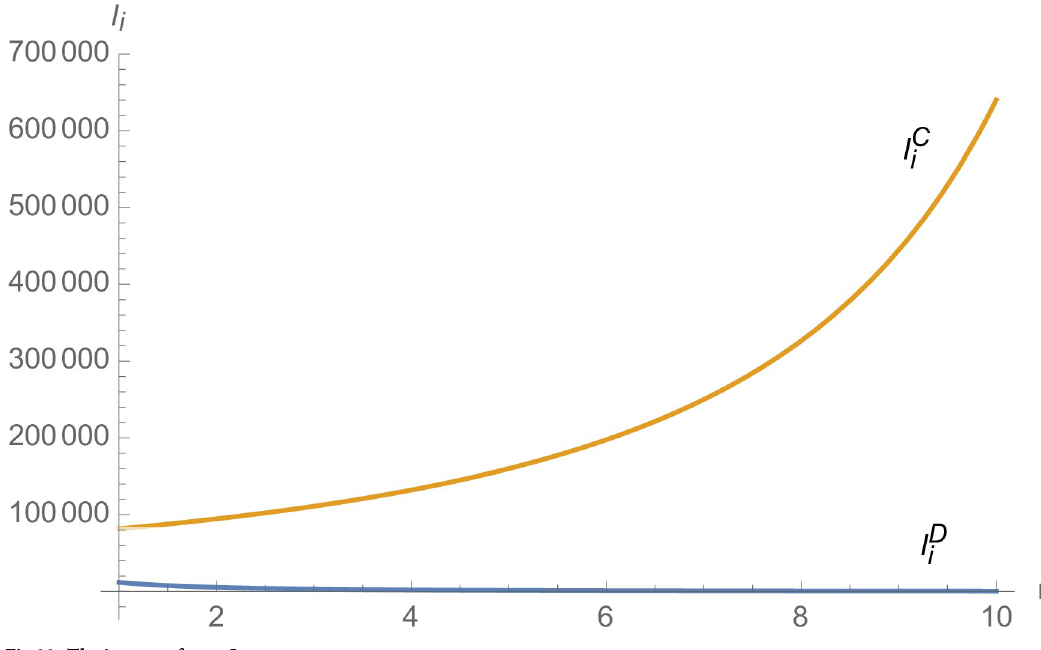
Fig 32. The impact of n on I